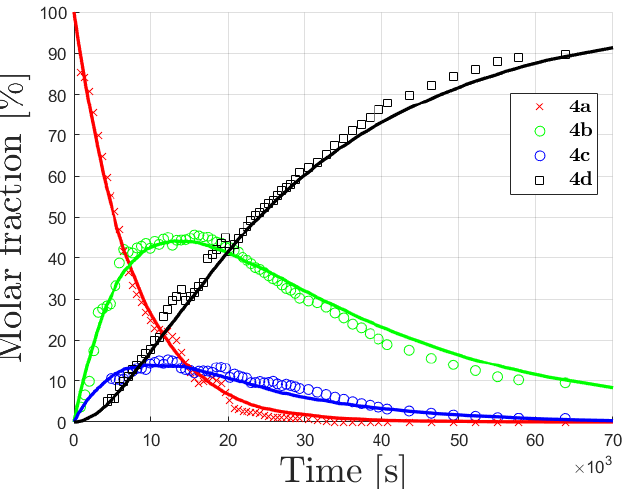
Figure 6. Experimental kinetic data and best-fitting curves obtained by the rate constants optimization for the deuteration process occurring on catechin at T = 300 K in D 2 O with 55 mM of acetic acid (CD 3 COOD), resulting in the calculated pH of 3.0.